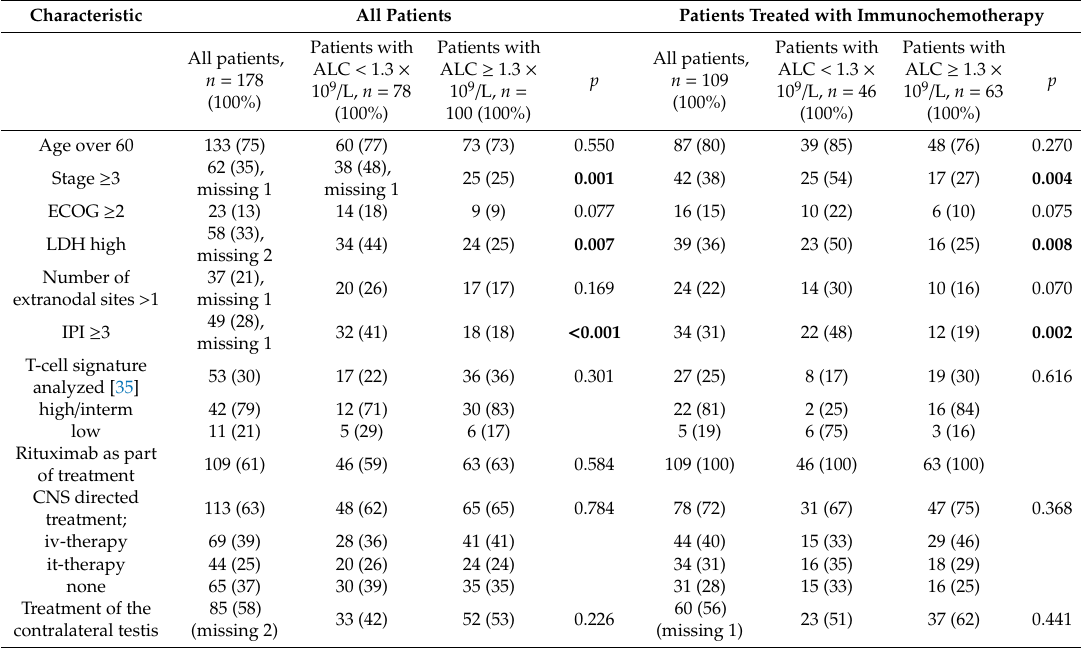
Table 1. Patient baseline characteristics.